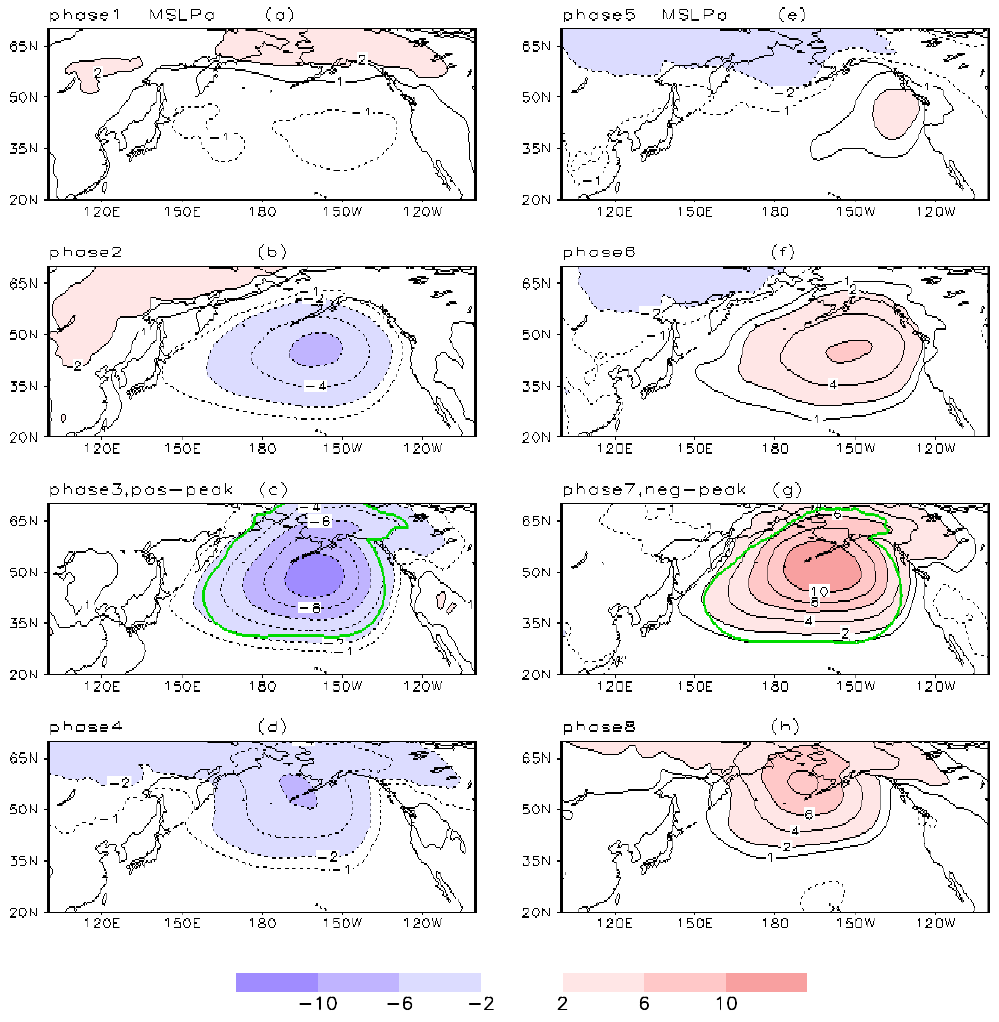
Figure 3. Life cycle composite of MSLP anomaly based on ALI in eight phases (hPa). Green contours in Figure 3c,g denote a significant area at the 95% confidence level. ( a ) to ( h ) corresponsing to phases 1 to 8.